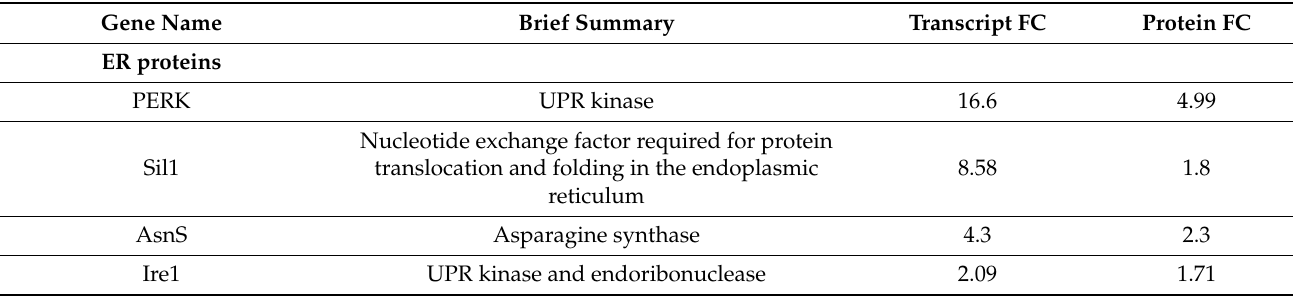
Figure 4. dPerk differential expression analysis (DEA). Comparison of dPerk-dependent fold change (FC) expression in the transcriptome and proteome (logged). Differentially expressed molecules are shown in red (adjusted false discovery rate (FDR) ≤ 0.05 and FC ± 1.6). The DEA shows a proportion of genes consistently regulated between the transcriptome and proteome (Pearson’s correlation, r = 0.5, p -value < 2.2 × 10 − 16 ) and a number of differentially regulated transcripts and proteins. The two subgroups of genes with upregulated transcripts, representing potentially protective pathways are indicated. Group 1 represents dPerk-dependent targets that show upregulation in both transcripts and proteins; group 2 represents translationally repressed targets that only show an upregulation of transcripts, with the absence of a change in protein levels. Group 3 represents targets that are repressed at both the transcript and protein level. dPerk and Nmdmc are indicated by black lines. Table 1. List of dPerk-dependent targets that show an upregulation of both transcripts and proteins (group 1). Gene name, brief summary of protein function and transcriptomic and proteomic analysis fold change values (FC) are presented. Abbreviations: ATP, adenosine triphosphate; ER, endoplasmic reticulum; GTP, Guanosine-5’-triphosphate; SLC22, Solute carrier family 22; UPR, Unfolded protein